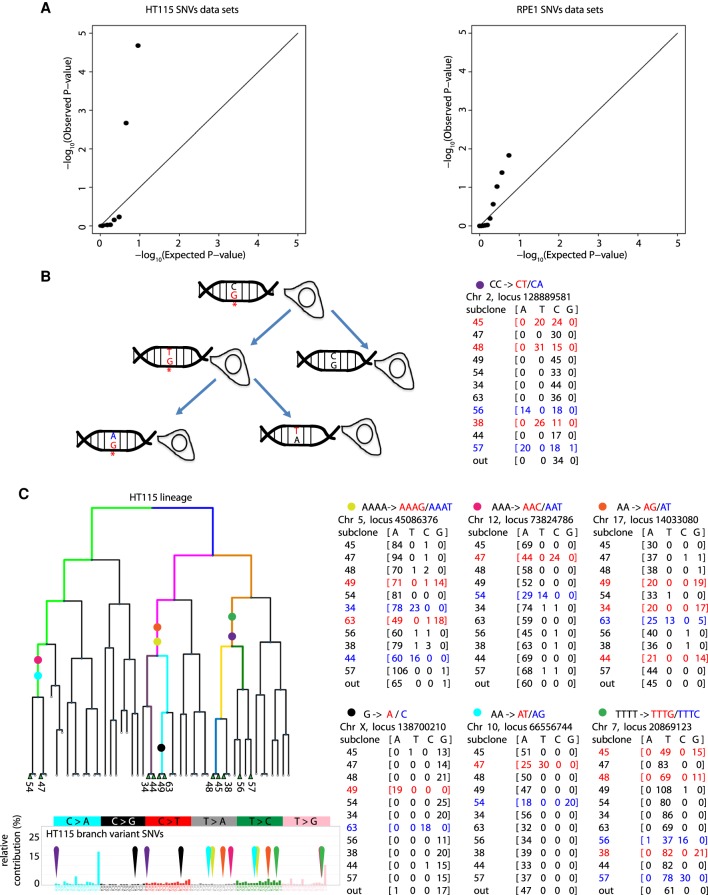
Intra-lineage heterogeneity in mutation rate and multiple mutation events. (A) Measured P-values from observed mutation counts are plotted vs. calculated theoretical (Poisson) P-values for the branch variant set for each sublineage to form quantile-quantile (QQ) plots (P-values for theoretical Poisson-distributed lineage-wise mutation count data versus observed data) for both HT115 (left) and RPE1 (right). The plotted points deviate strongly from the expected distribution (which would follow an x = y relationship) at both ends of the distribution, showing that the sublineages present in each data set cannot be plausibly modeled by a Poisson distribution based on independent mutations. (B) Schematic showing persistent lesion hypothesis for correlated same-site mutation. DNA lesions (marked as G*) that are not repaired during S-phase compel the DNA polymerase to replicate opposite lesion bases with a high probability of mutation. If the lesion has not been repaired before the next S-phase in the daughter cell carrying the lesion, an additional mutation at the identical genomic locus is likely to result. If the second mutation is different from the first, this process can be readily detected from lineage sequencing data. The example scheme represents the CC > CT and CC > CA mutations we detected at the Chromosome 2 locus 128889581 (marked with purple circle). (C) Seven multiple mutation events were found in the HT115 lineage. Read counts for each example are presented and marked with a colored symbol. The lineage segment where each example occurred is shown (with corresponding colors). None of these events overlap the most probable mutation types found in the POLE signature.